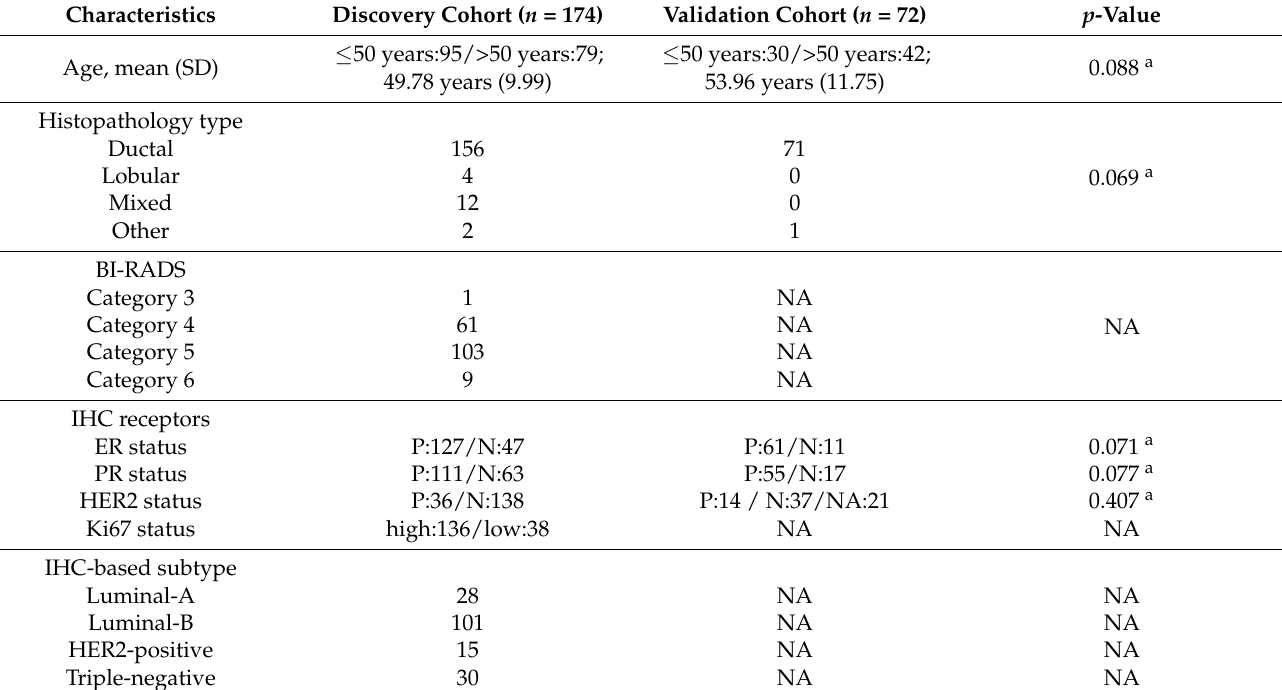
Table 1. Demographics of BC patients in the imaging-subtype discovery and validation cohorts. cohorts. The patient distribution of the two cohorts was not different except for the PAM50 molecular